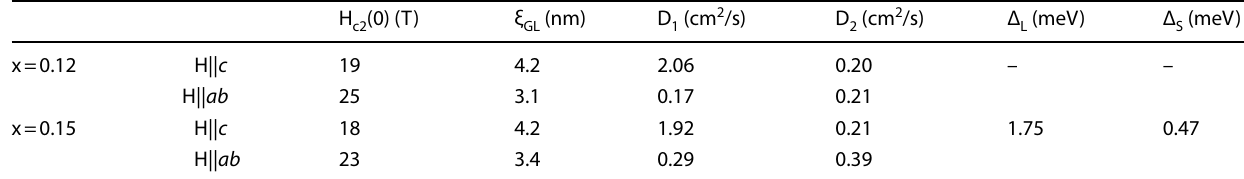
Table 1 Summary of the parameters for the upper critical field (R = 0 criterium) and energy